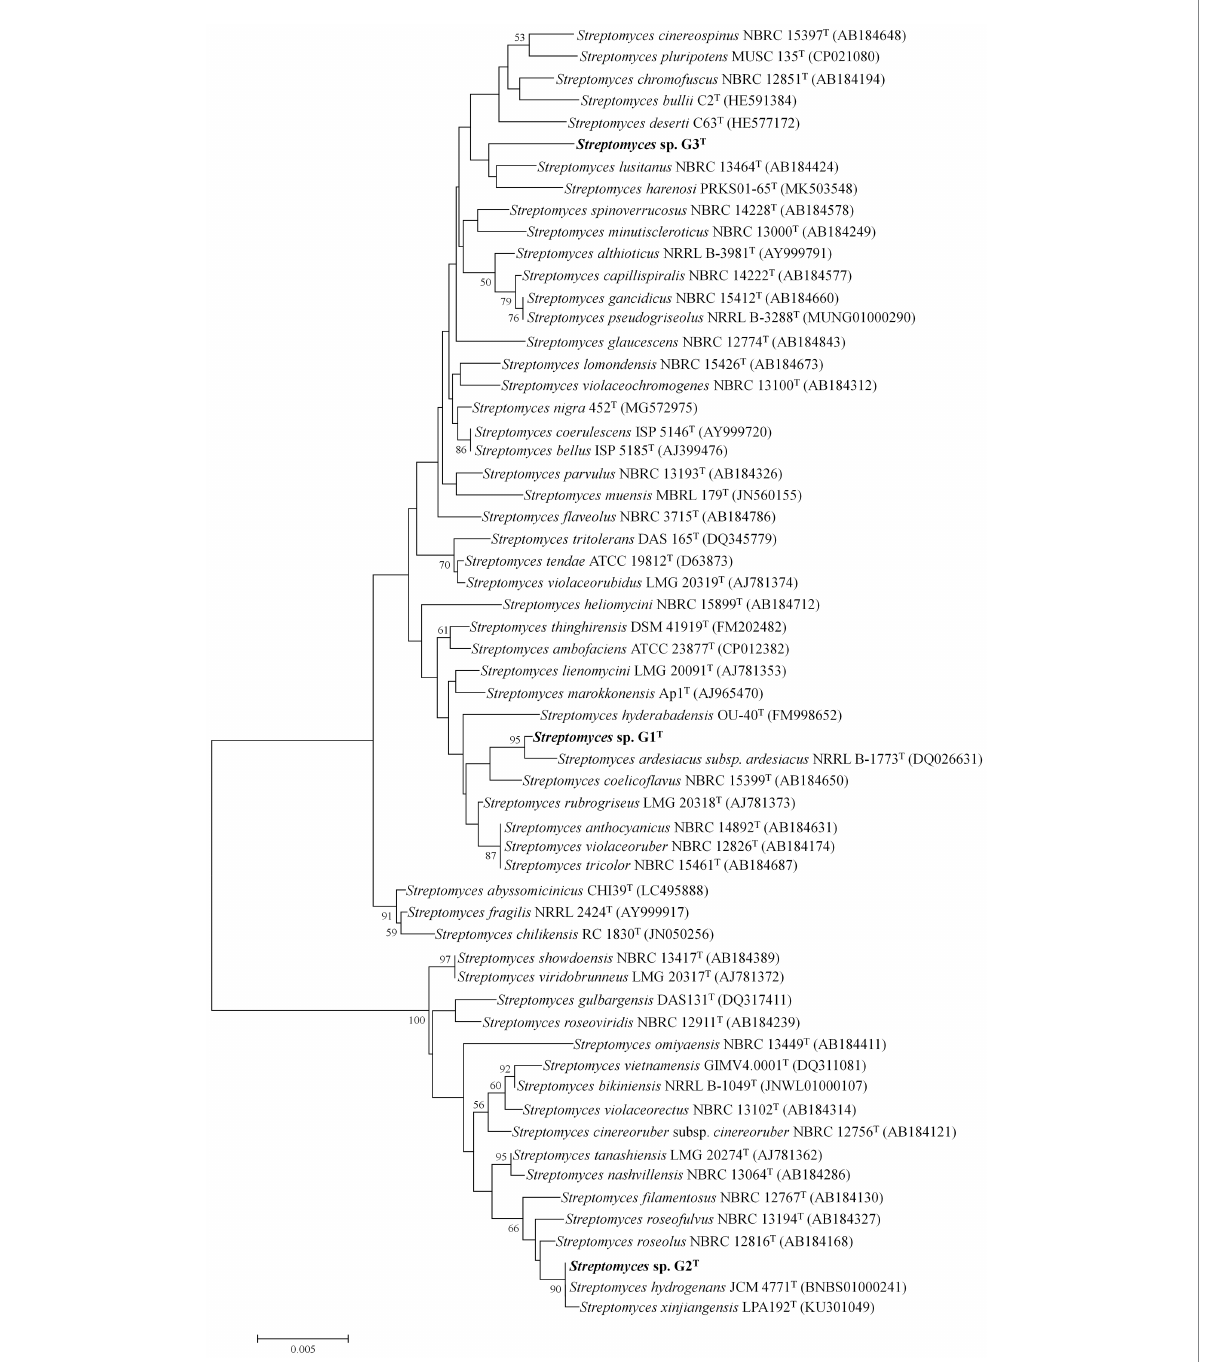
FIGURE 1 Neighbor-joining tree showing the phylogenetic position of species Streptomyces sp. G1 T , Streptomyces sp. G2 T , Streptomyces sp. G3 T and related taxa based on 16S rRNA gene sequences. Only bootstrap values above 50% (percentages of 1,000 replications) are indicated. Bar, 0.005 nucleotide substitutions per